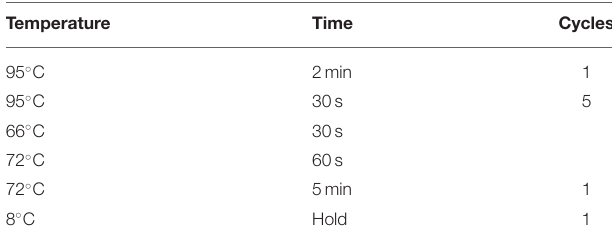
TABLE 2 | The procedure details of the second round of PCR (“indexing